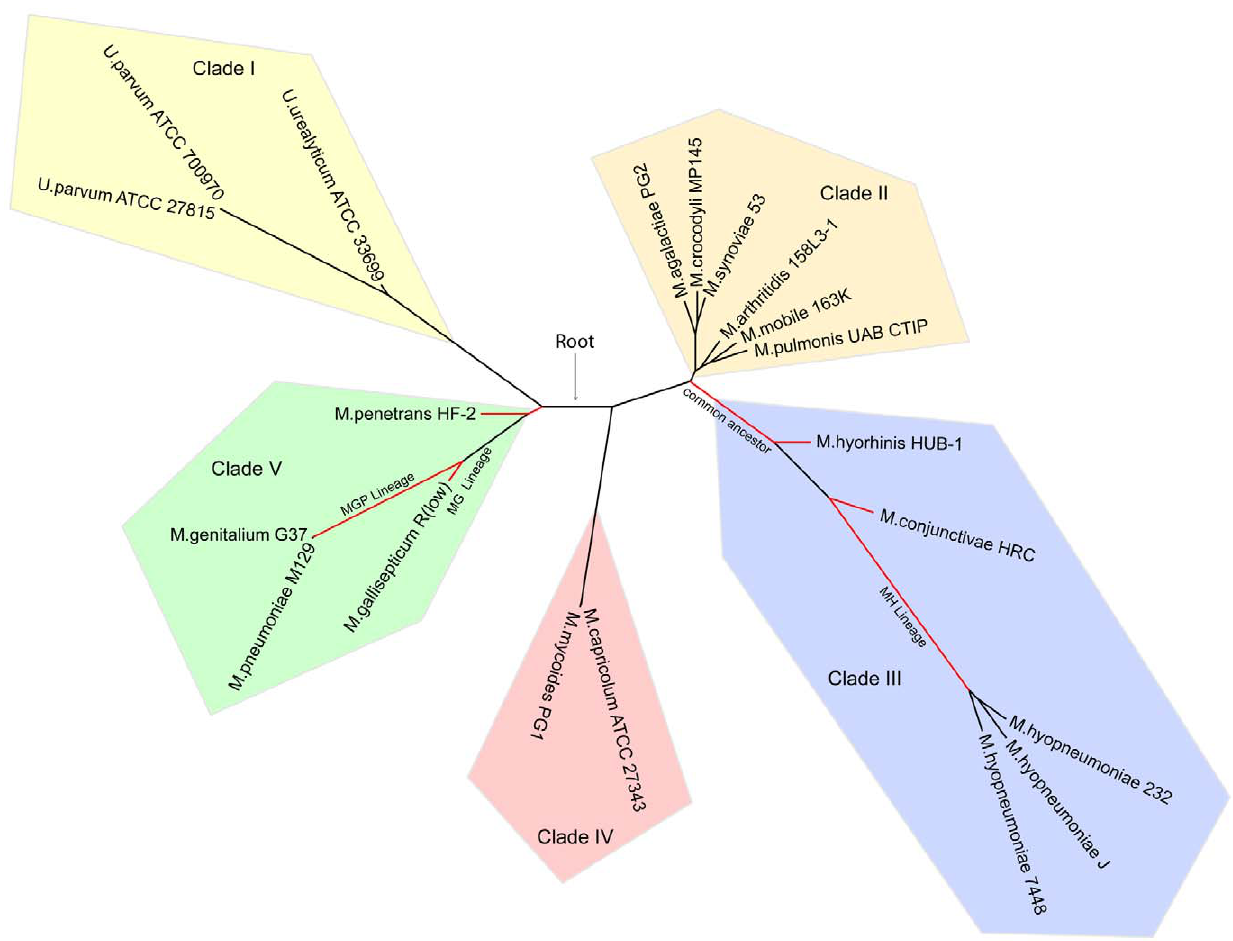
Figure 4. Phylogenetic tree of Mycoplasmataceae . The phylogenetic relationship was estimated and tested in one thousand bootstrap samples using TREE-PUZZLE version 5.2 with a BIONJ model (see Materials and Methods). This supertree shows five major distinct clades. The four lineages that were used as foreground in the branch-site model positive selection test are highlighted in red.